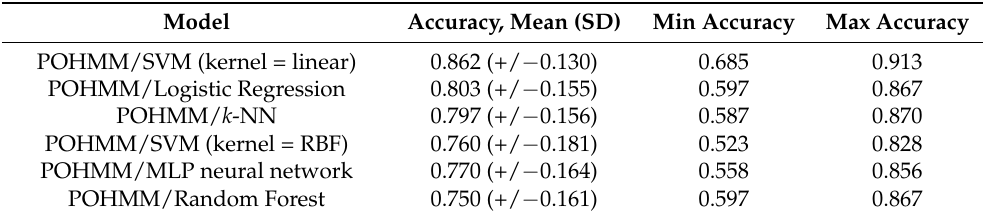
Table 5. Different hybrid models’ accuracy on POHMM emission